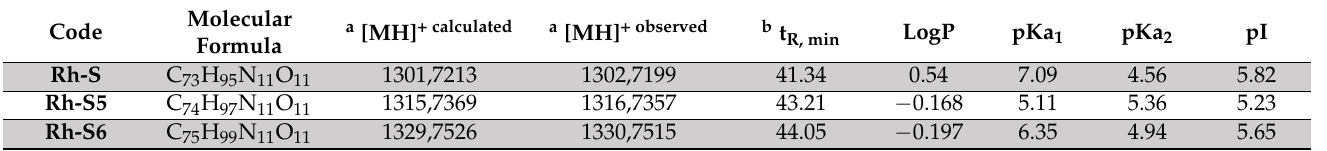
Figure 1. FTIR transmission spectra of Rh-S, Rh-S5, and Rh-S6. Table 1. Analytical data of new synthetic spinorphin peptides.